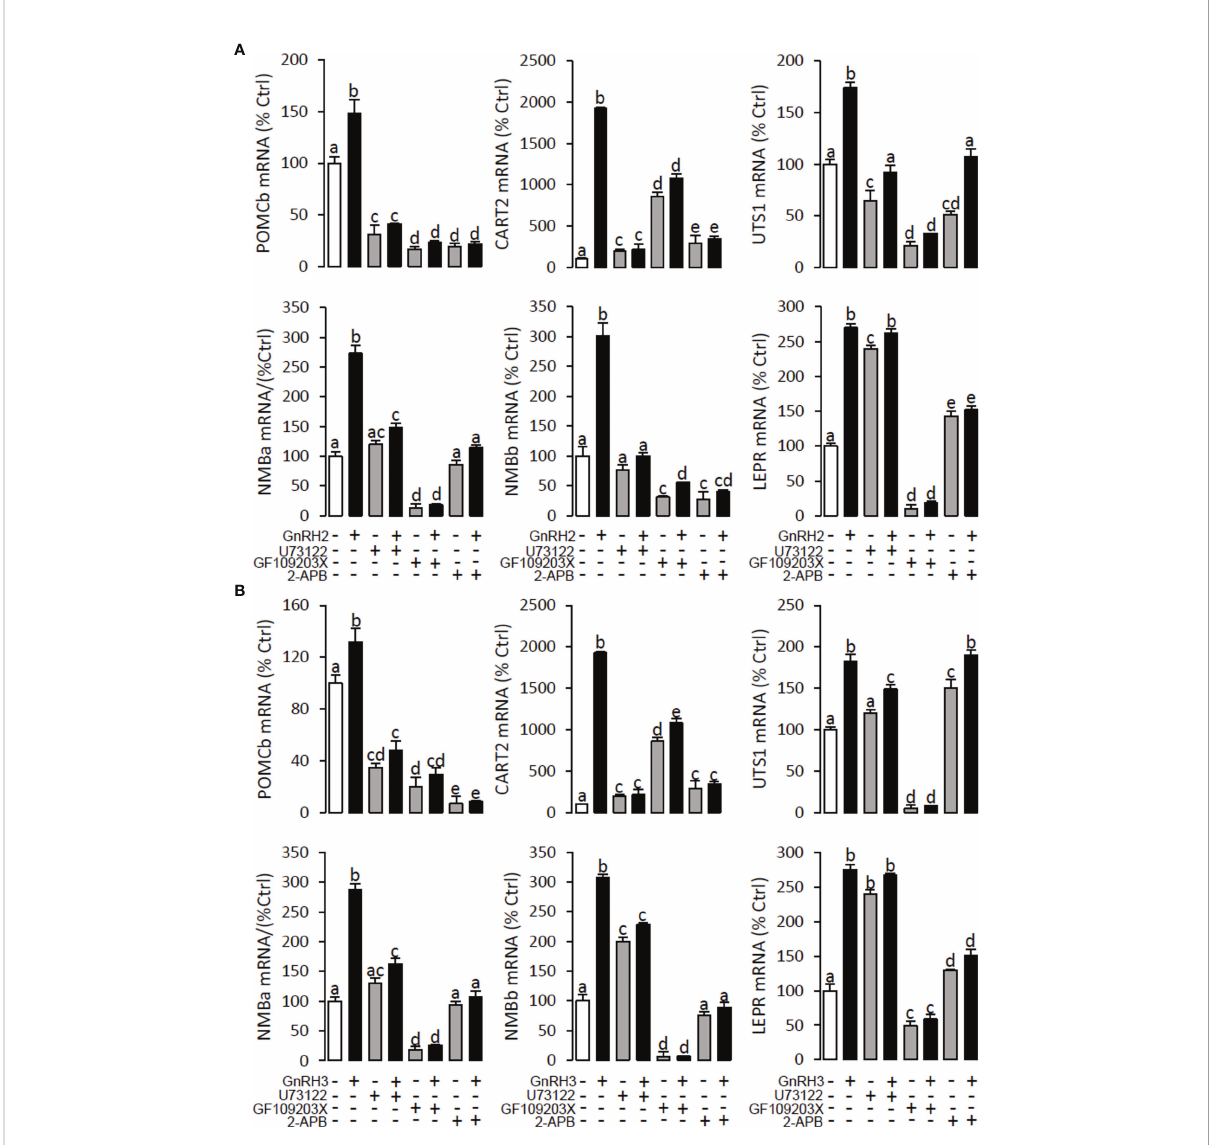
FIGURE 10 Signal transduction for GnRH2- and GnRH3-induced POMCb, CART2, UTS1, NMBa, NMBb, and LEPR mRNA expression in grass carp pituitary cells. In this experiment, GnRH2 (A) or GnRH3 (B) combined with / without the PLC inhibitor U73122 (10 m M), PKC inhibitor GF109203X (20 m M), or IP3 receptor blocker 2-APB (100 m M) was used to incubate the grass carp pituitary cells for 24 (h) After drug treatment, the total RNA was extracted from the cells for real-time PCR of the respective genes. Data presented are expressed as mean ± SEM, and the different letters represent a signi fi cant difference at p < 0.05 between groups (ANOVA followed by a Dunnett